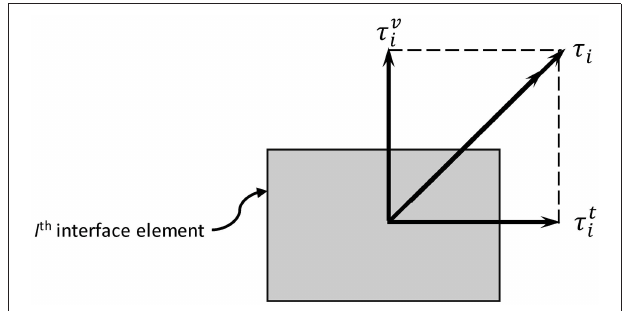
FIGURE 2 | Addition of interface stresses in coupled analysis. FIGURE 3 | Flowchart for the FORTRAN program